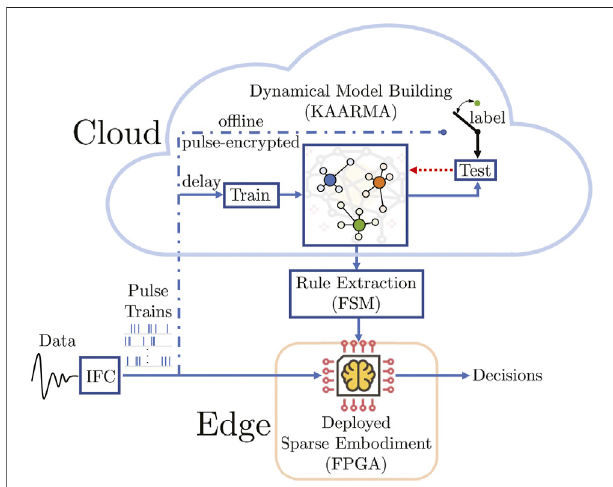
FIGURE 1 | Sparse Embodiment Neural-Statistical Architecture (SENSA):oncelearningparametersaretrained,theinput-outputmappingcan be easily approximated using memory-based techniques augmented with rule-based fi nite state machine (FSM) for rapid deployment in hardware (FPGA). We call this speci fi c formulation using kernel methods for model building Sparse Pulse Automata via Reproducing Kernel (SPARK).